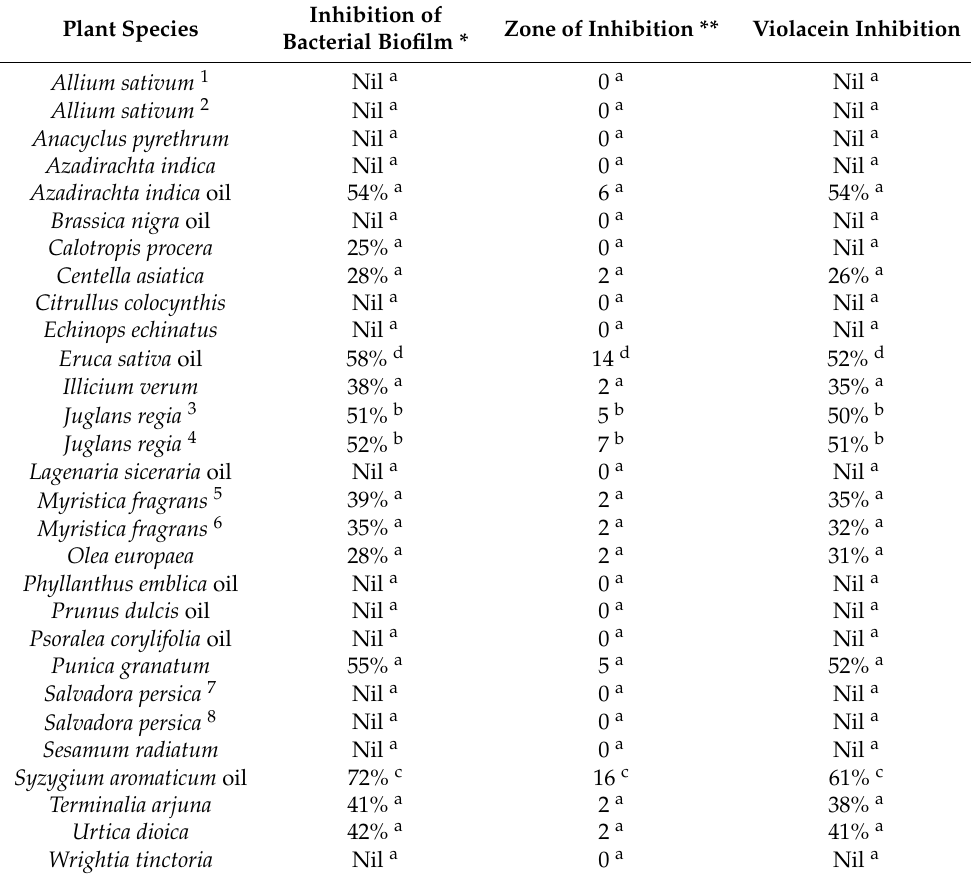
Table 4. Antibiofilm and antiquorum-sensing activity of plant extracts and essential/fixed